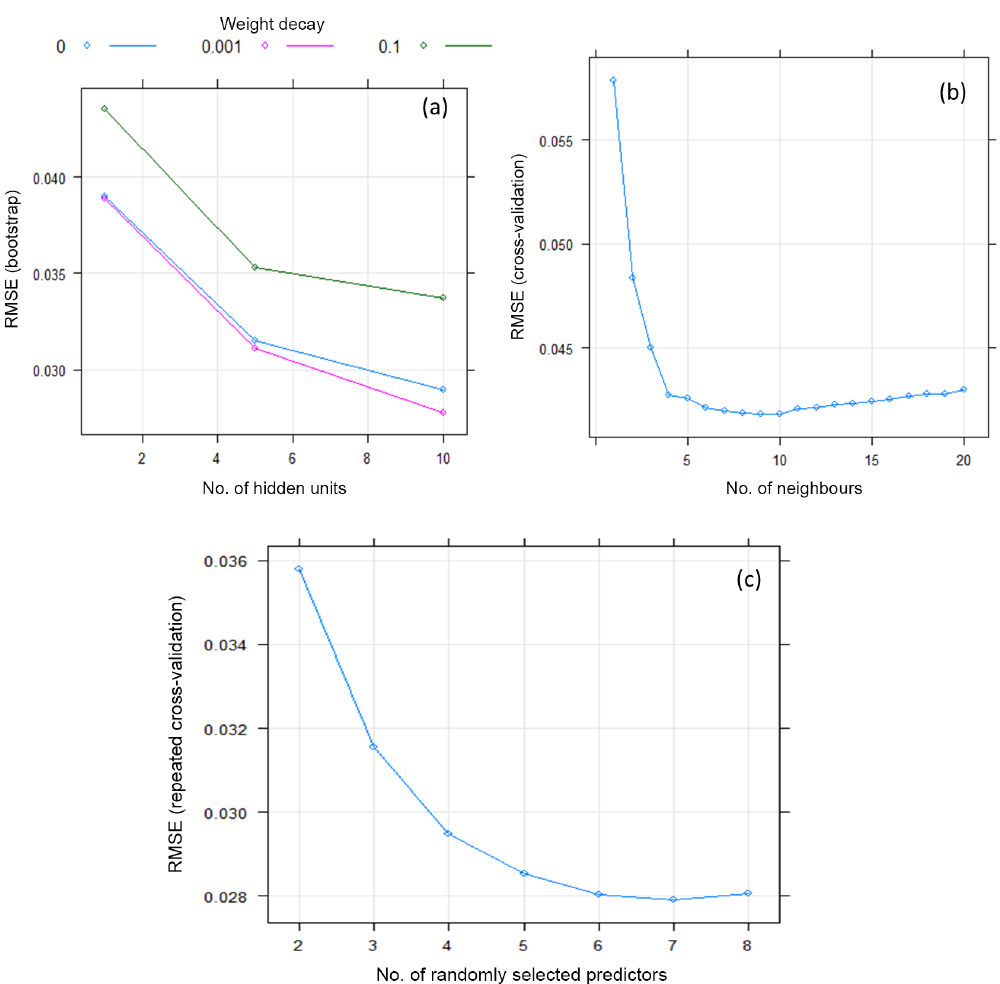
Figure 10. Bootstrap and cross-validation-based estimates of hyper-parameter values for the three machine-learning models, i.e. NNET (a) , KNN (b) , and RF (c) , in a sample calibration period (year